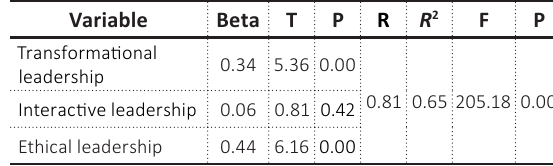
Table 4. Model fit quality indicators for data